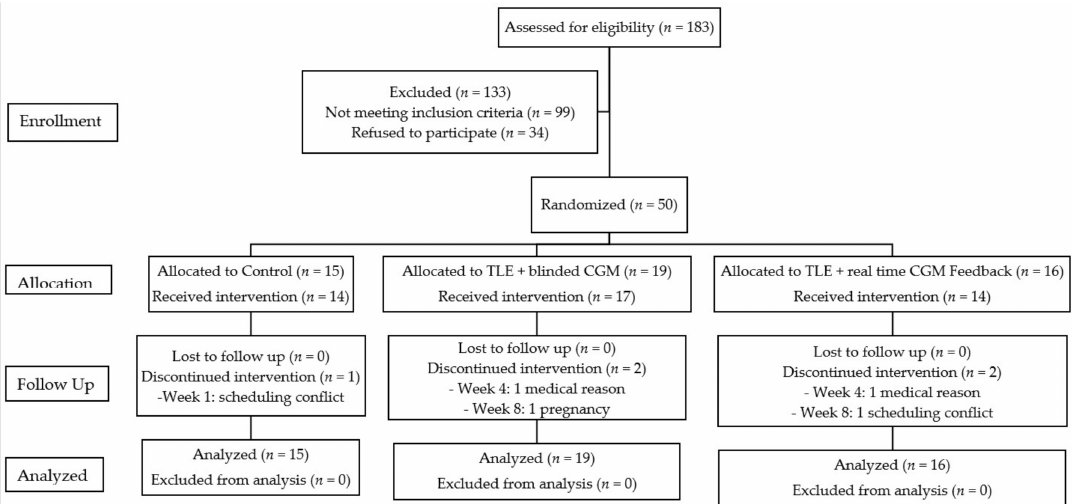
Figure 1. Consolidated Standards of Reporting Trials (CONSORT) flow diagram of participant